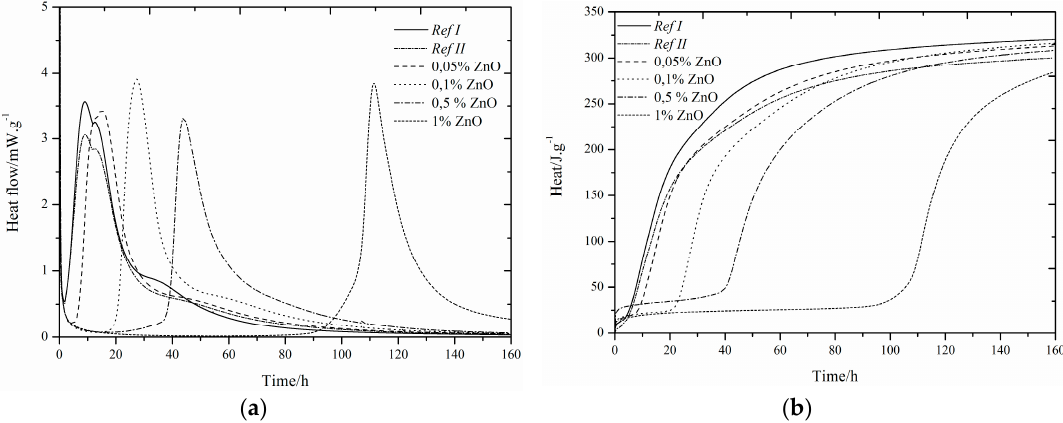
Figure 6. Differential ( a ) and integral ( b ) curves measured for the addition of ZnO. Figure 6. Di ff erential ( a ) and integral ( b ) curves measured for the addition of